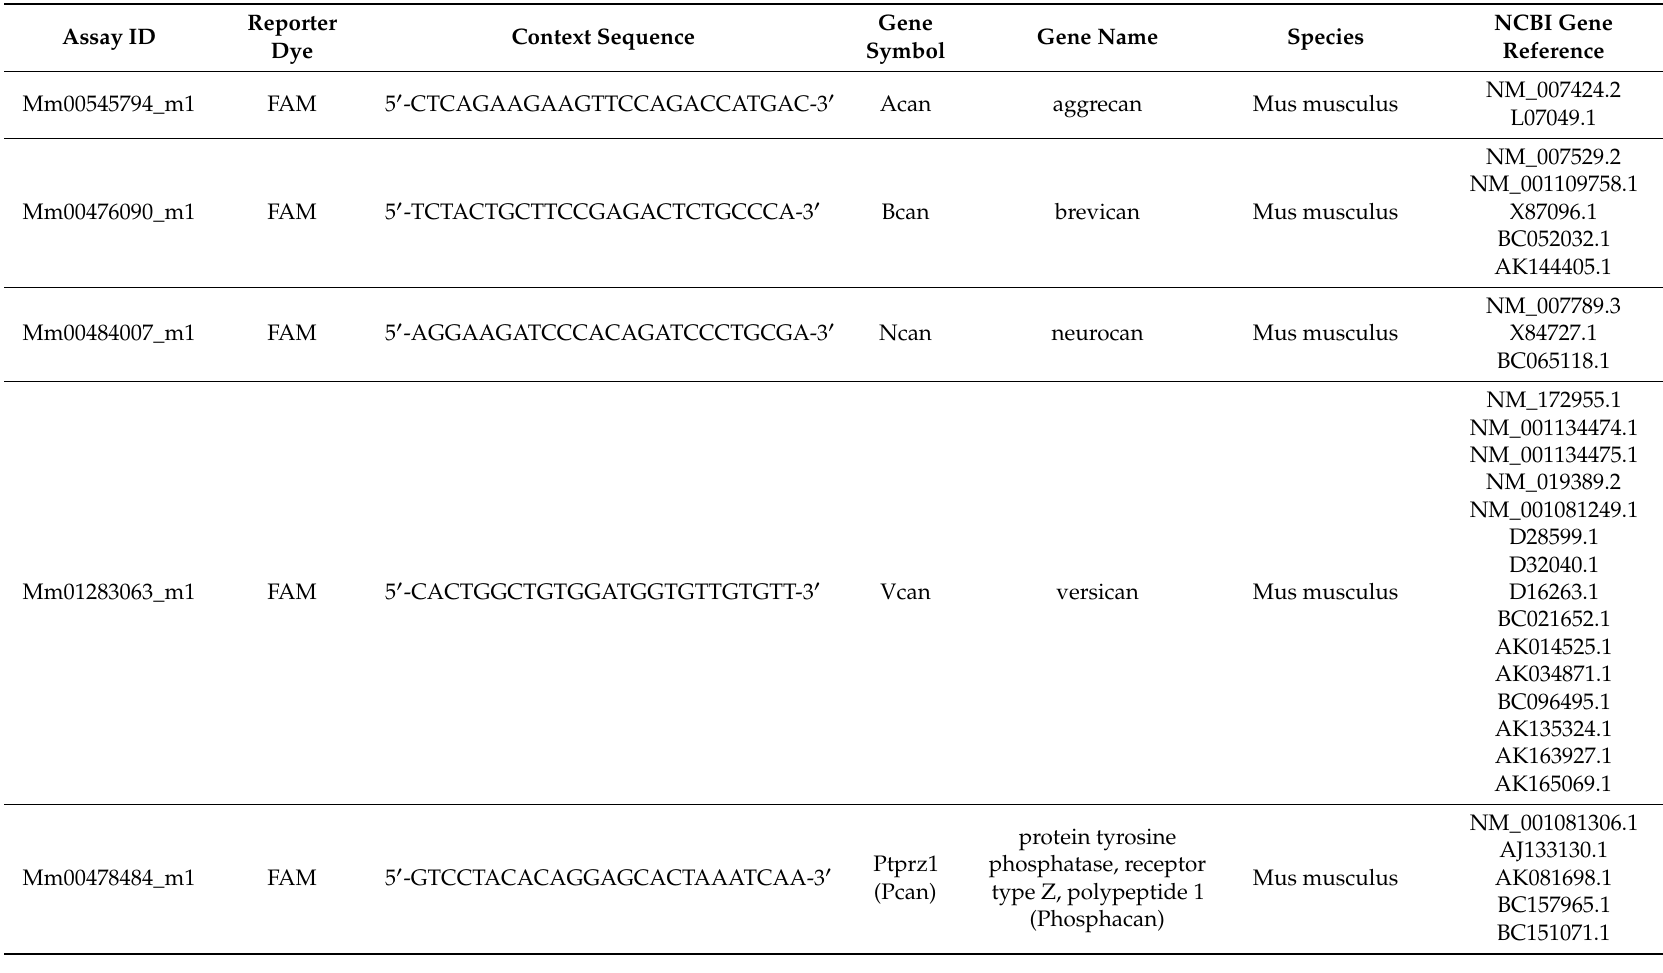
Table 1. Primers used in this